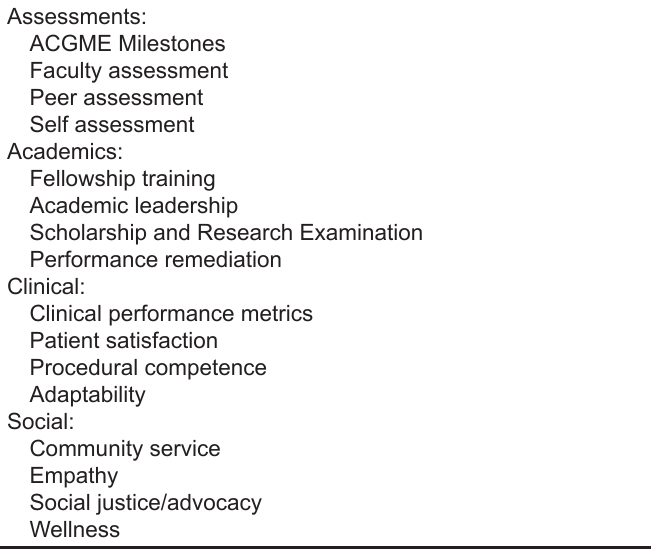
Table 1. Metrics of resident